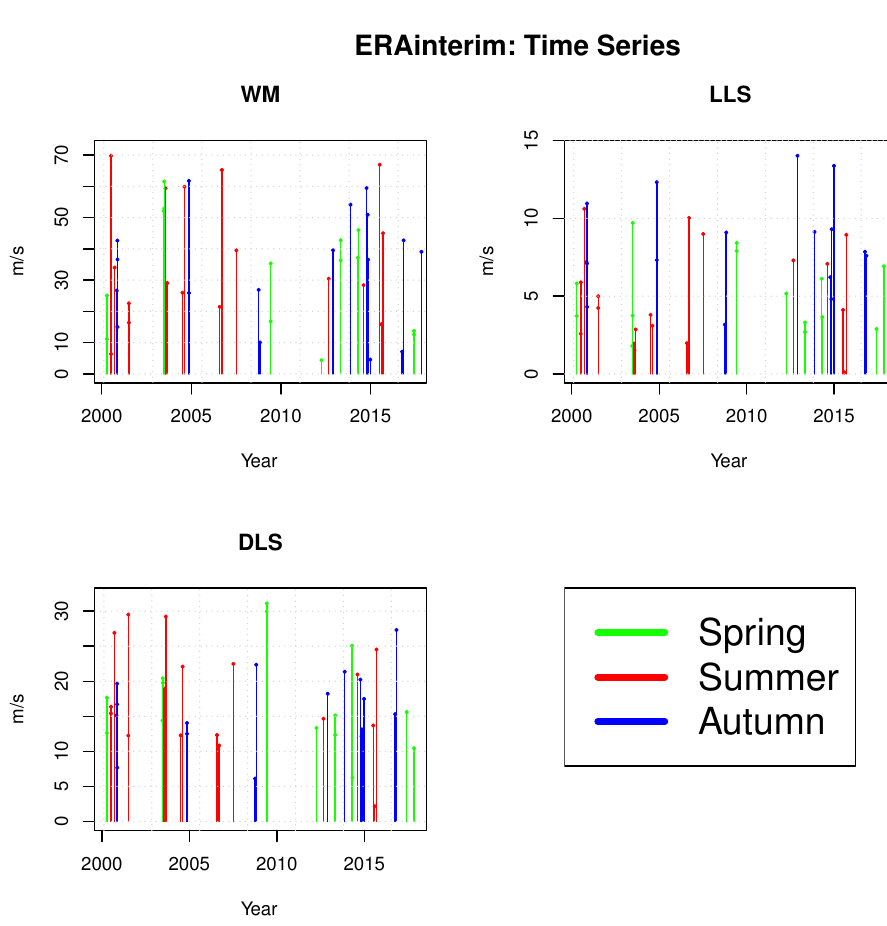
Figure A1. Same as Figure 2 but considering the ERA-Interim